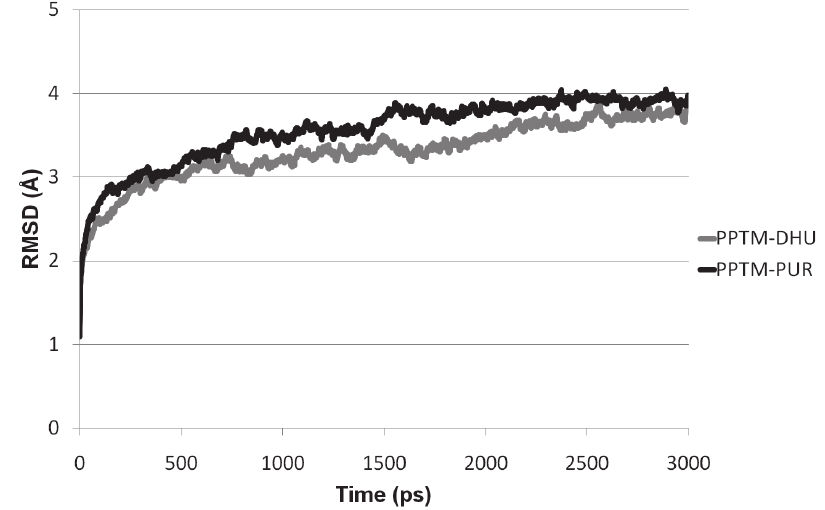
Figure 3 - Root mean square deviation (RMSD) of the putative phosphoribosyltransferase from Meloidogyne incognita , during the molecular dynamics simulation of the complex of this enzyme with dihydrouracil (PPTM-DHU) and 9 H -purine (PPTM-PUR).